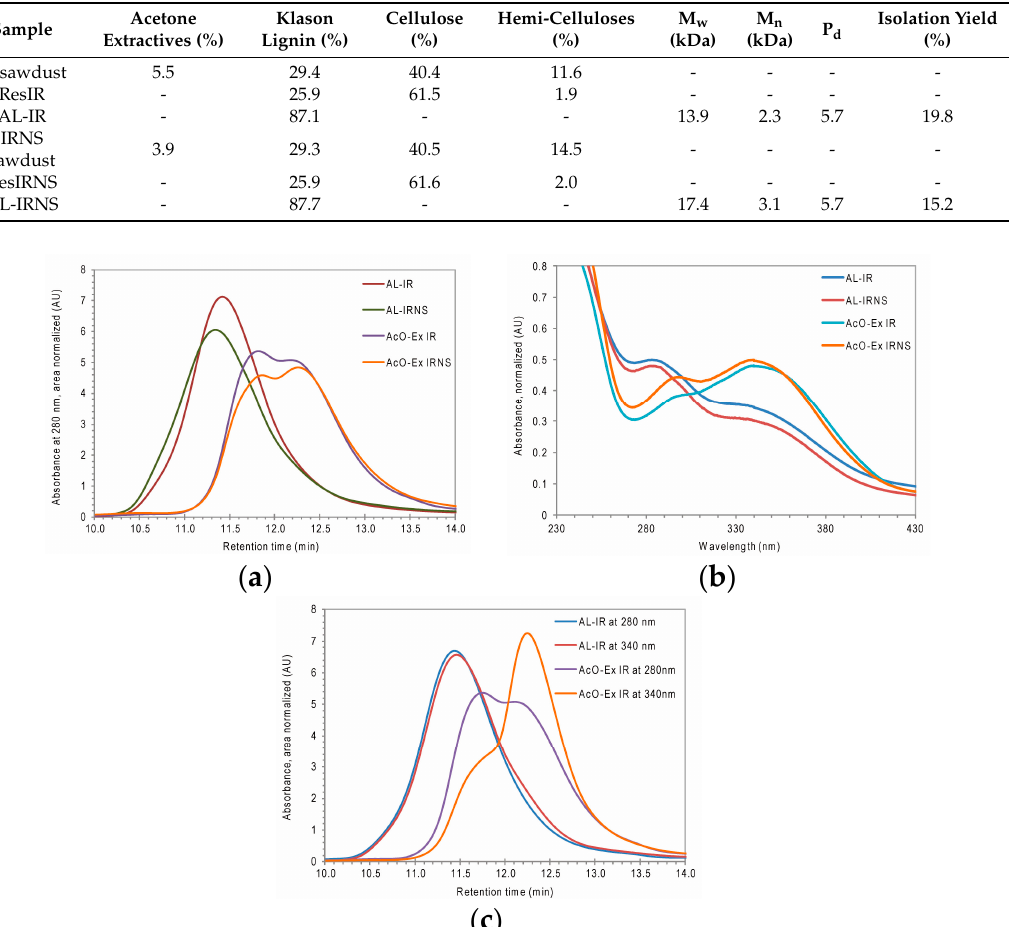
Figure 1. ( a ) HP-SEC elution profiles at 280 nm of the acidolysis fractions from Iroko and mixed sawdust of Iroko and Norway spruce (AL-IR and AL-IRNS) as well as their respective acetone-extractives fractions (AcO-Ex IR and AcO-EX IRNS); ( b ) UV-VIS spectra (230–430 nm range) of AL and AcO-Ex fractions from IR and IRNS; ( c ) HP-SEC elution profiles at 280 nm vs. 340 nm of AL-IR and AcO-EX IR.